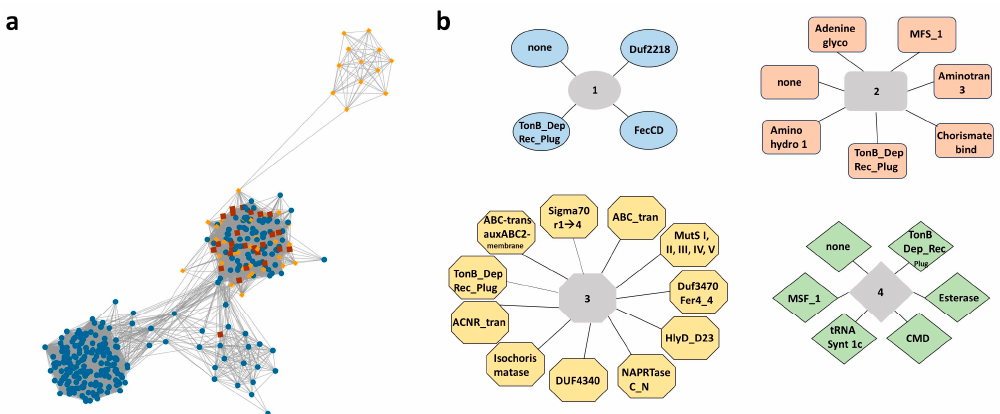
Figure 1. Genome neighborhood analysis of VCA0231. ( a ) Sequence similarity network (SSN) constructed for the product of VCA0231 using the enzyme similarity tool from EFI. Nodes represent protein orthologs of the product of VCA0231 in species from α -Proteobacteria (blue octagons), β -Proteobacteria (red rectangles) and γ -Proteobacteria (yellow circles). ( b ) Pfam families associated with each cluster of the SSN, as determined by GNT.